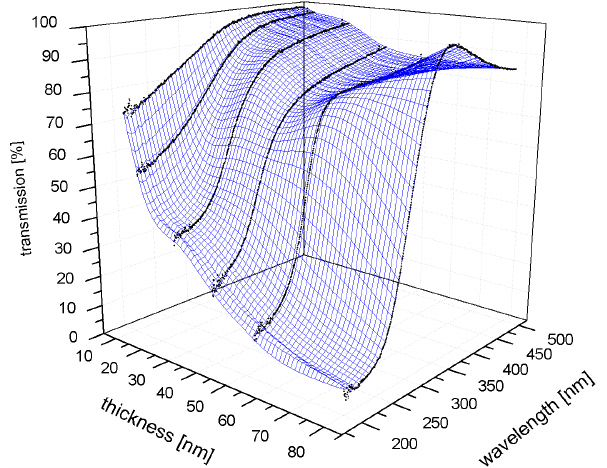
Figure 7. Transmission of the bottom electrode ITO in relation to film thickness and used wavelength (Zimmer et al., 2013).